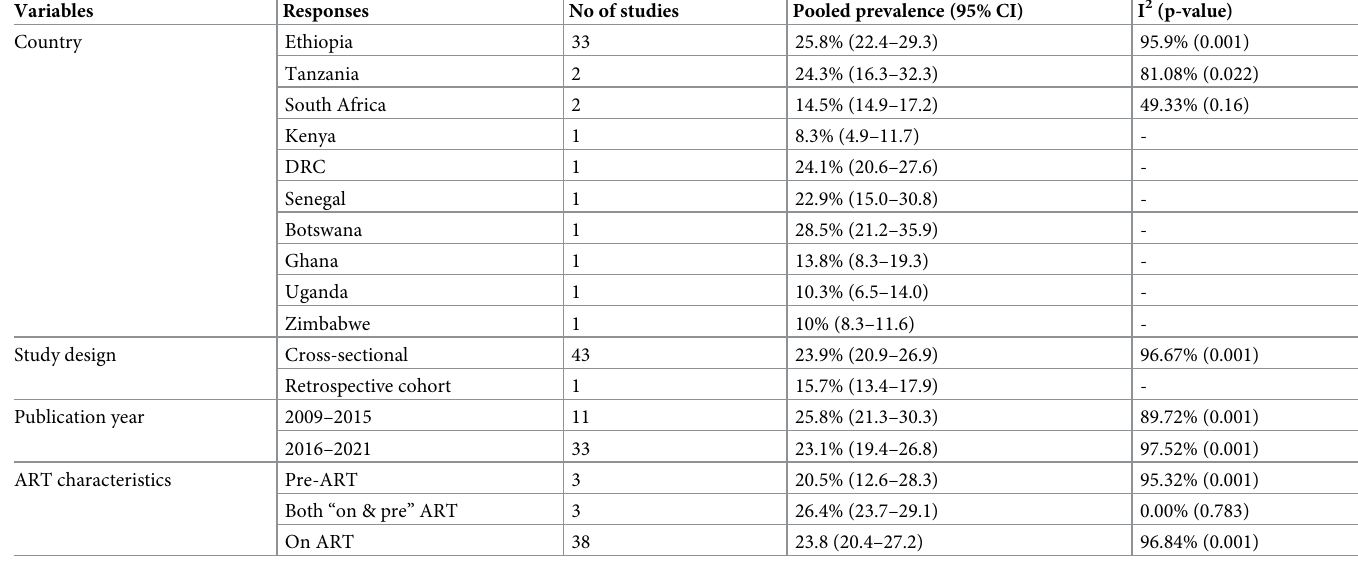
Table 3. Sub-group analysis of the prevalence of undernutrition among adults living with HIV in sub-Saharan Africa by country, study design, and publication year, 2009–2021.